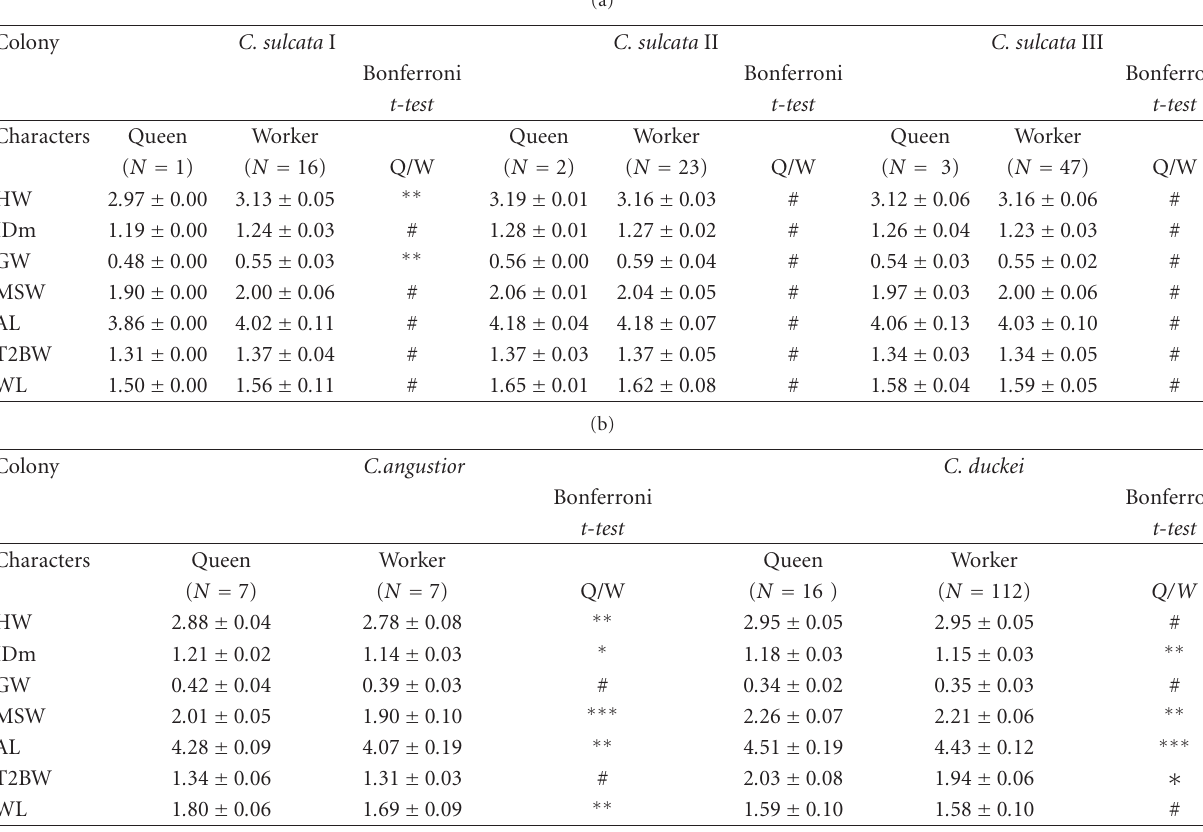
Table 2: Means, standard deviations, and F values of ANOVA for the analyzed colonies of the genus Clypearia .